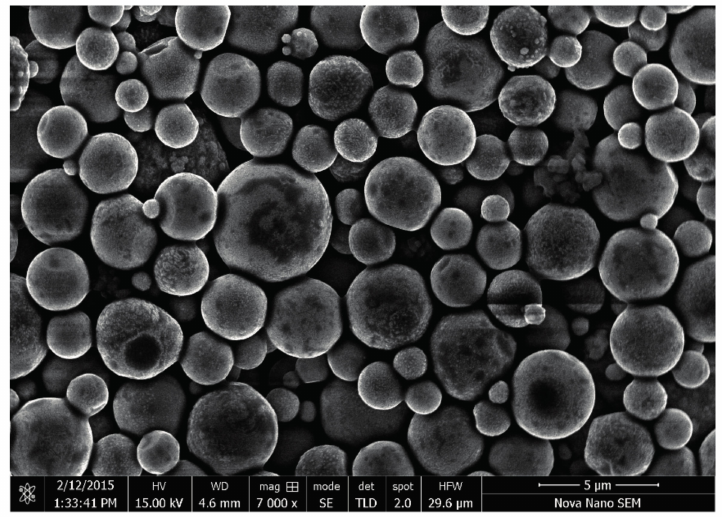
Figure 1. Dispersion of Zn particles in the acrylic resin showing the large inter-particulate contact. The average dry coating thickness of 35 ± 1 µ m of the electroplated and cold gal- vanized coating was obtained by optimizing the coating application conditions. How- ever, compared to the DS sample, a relatively large variation in the coating thickness (approx. ± 10%) was observed in the case of the BS sample, possibly due to the variation in the manually applied coating procedure. The average roughness ( R a ) of the zinc electro- plated sample was 0.45 µ m whereas dipped and brushed cold galvanized samples have presented average roughness of 0.80 and 1.15 µ m, respectively. The relatively large surface roughness of the cold galvanized coating applied via brushing was related to the inhomo- geneity in the manually applied coating. The electroplating of zinc on the surface produced a refined grain structure and resulted in a smooth surface. The relatively higher roughness of the dip-coated sample compared to the electroplated one was possibly related to the micro-sized dispersed Zn particles in the acrylic resin. But the machined controlled dipping and removal of the steel panels (DS samples) could produce a smooth and homogenous surface and resulted in relatively low surface roughness compared to the BS